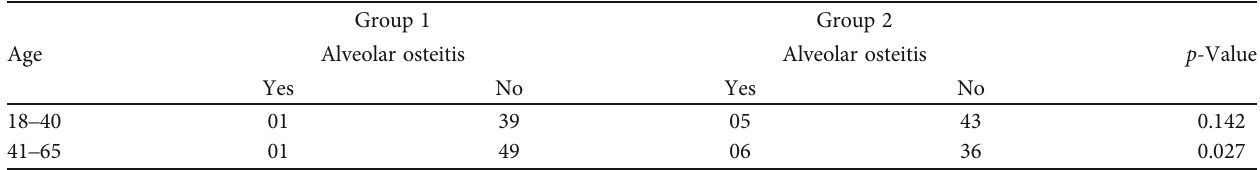
T ABLE 4: Strati fi cation of alveolar osteitis with respect to age groups.